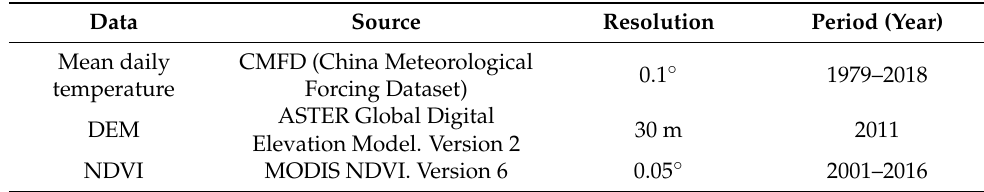
Table 2. The information of data products in the study.